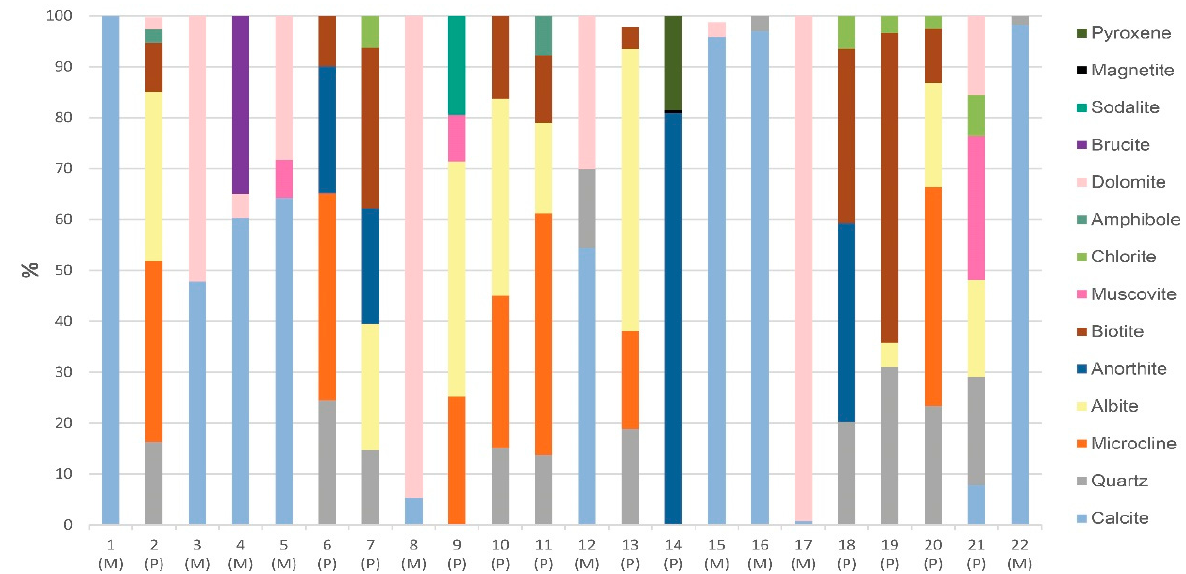
Figure 5. X-ray diffraction (XRD) results for samples used in this study; (M) marble, (P) plutonic.